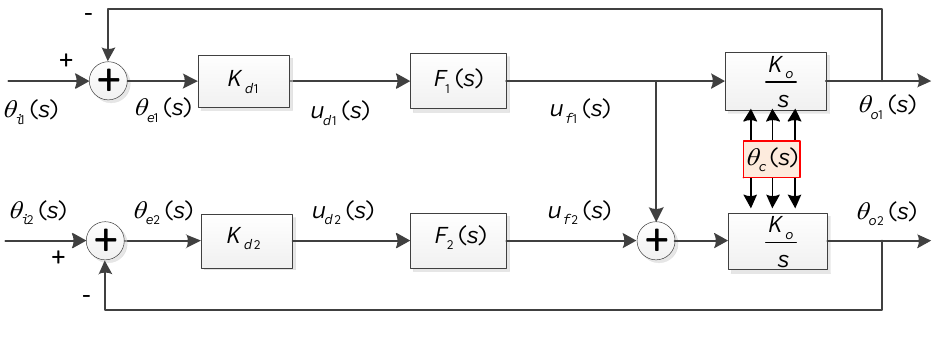
Figure 2. Tracking loop structure of the dual antenna